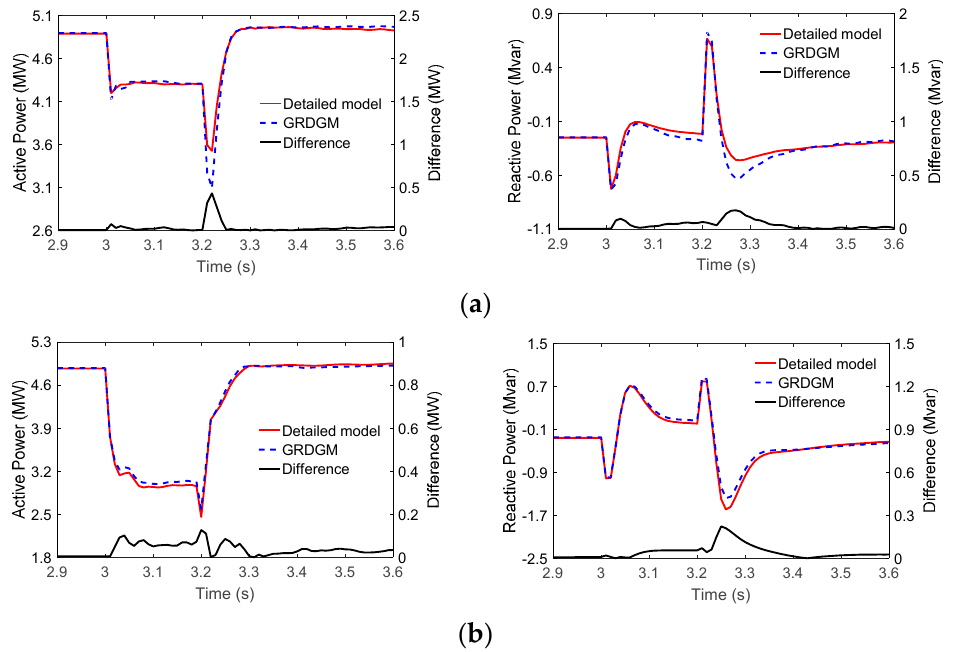
. % U voltage dip disturbance at B 2 . ( b ) 39 n